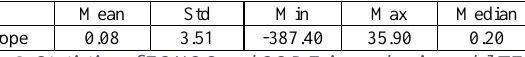
Table 3. Statistics of EGNOS and CODE ionospheric model TEC